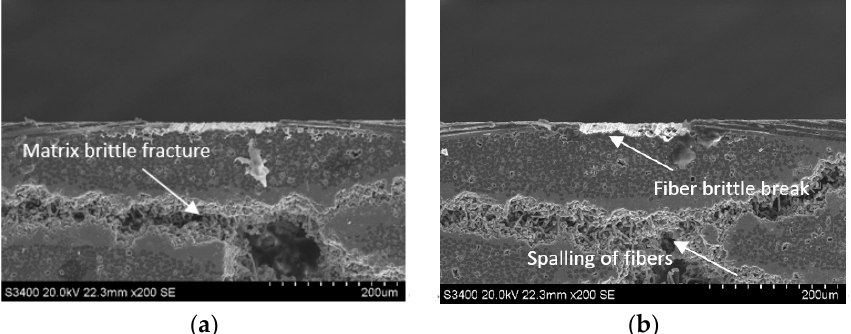
Figure 11. Brittle fracture and peeling damage of the carbon fibers on the subsurface of the C/SiC composite after side face grinding. ( a ) SiC matrix area defects. ( b ) Carbon fiber